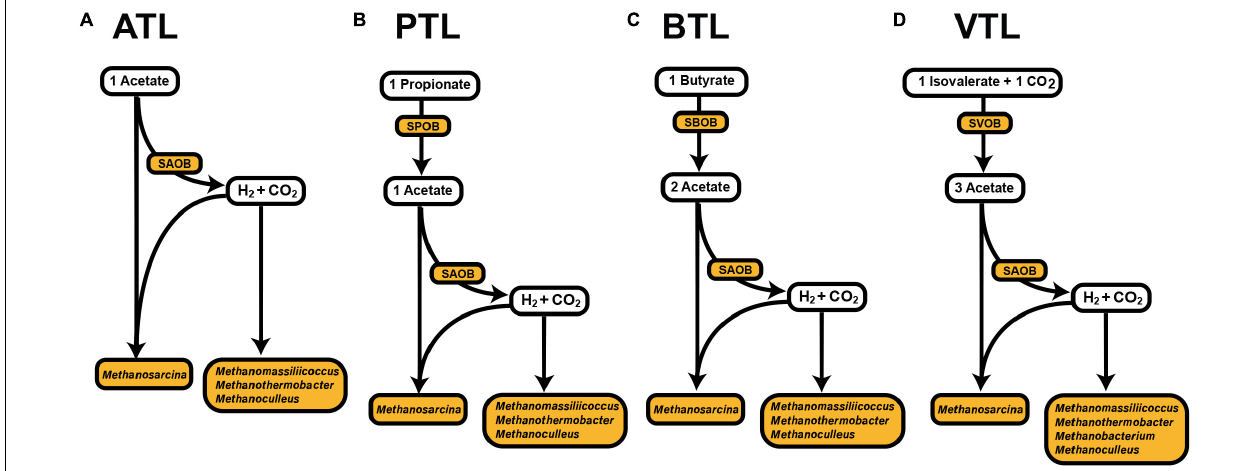
FIGURE 1 | Proposed main carbon flow in methanogenic process in the four anaerobic chemostats (Chen et al., 2020a, b; Zheng et al., 2019). The ATL (A) , PTL (B) , BTL (C) , and VTL (D) represent the thermophilic methanogenic chemostats supplemented with acetate, propionate, butyrate, and isovalerate as sole carbon source,